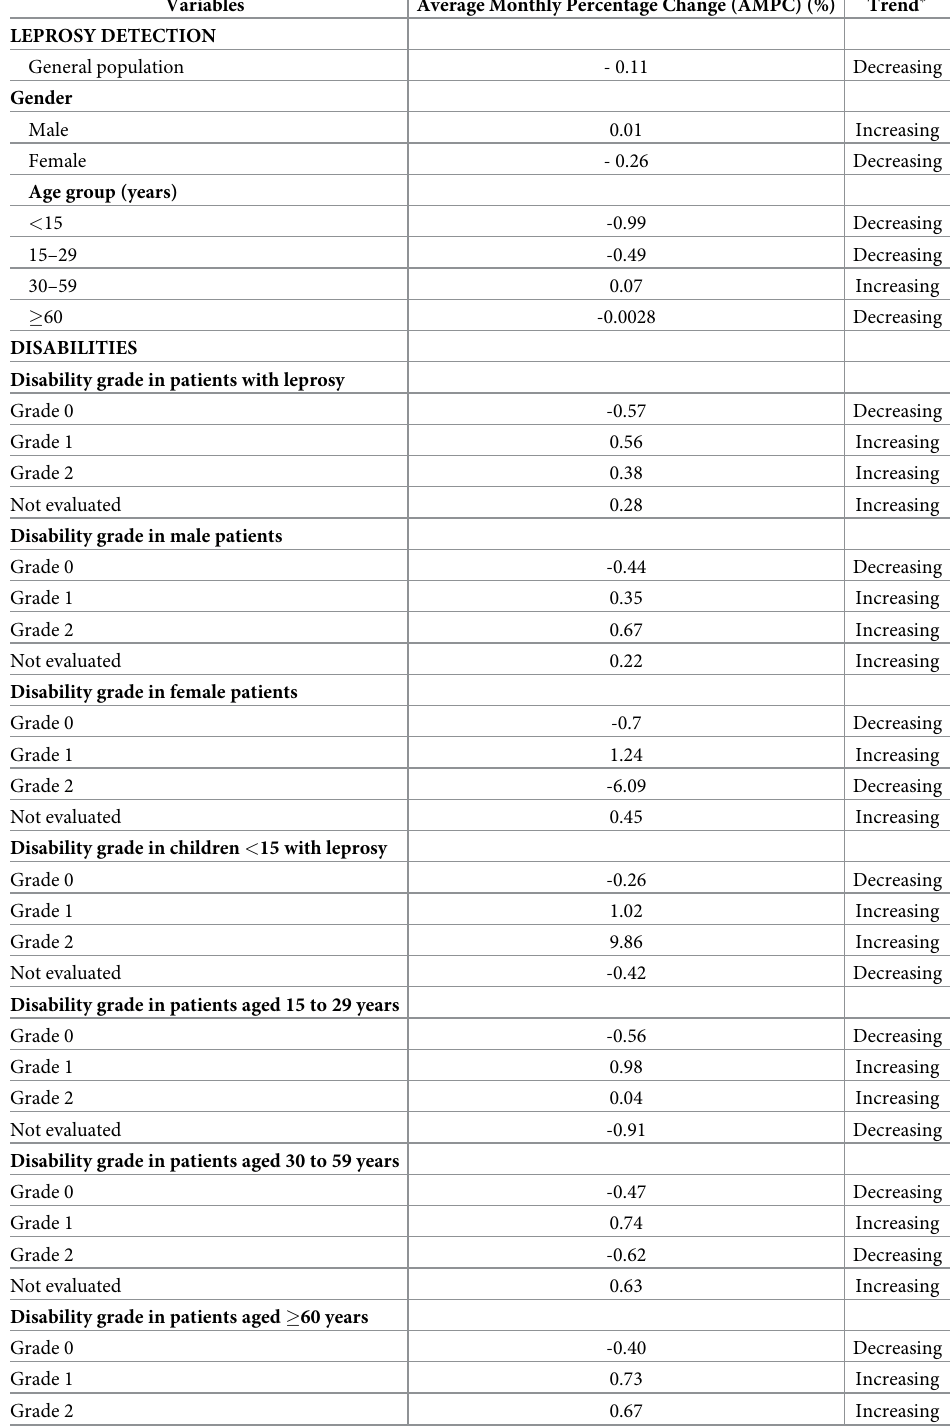
Table 3. Mean percentage variation in the rates of detection of leprosy and disability grade at the time of diagno- sis of cases, in an endemic municipality in Central-West Brazil